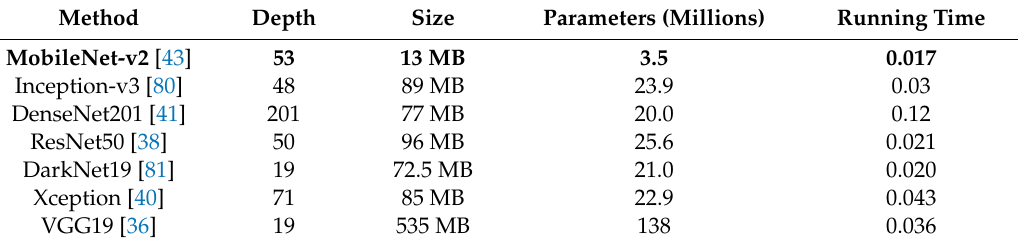
Table 5. Performance of facemask-wearing condition identification network.